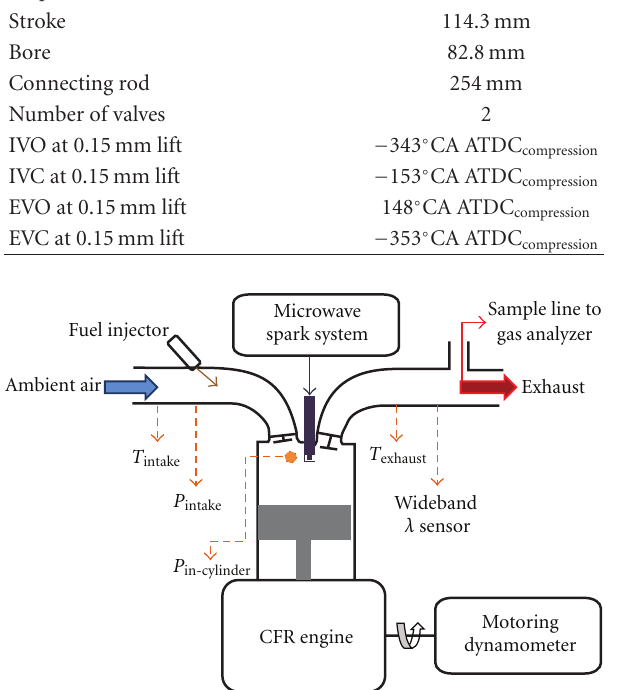
Figure 1: Schematic of Cooperative Fuel Research (CFR) engine with microwave-assisted spark plug system. Sensors are marked with dashed